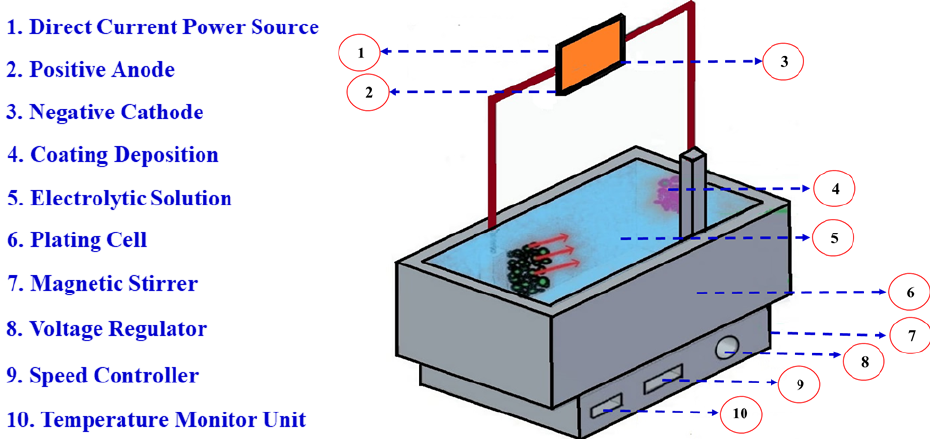
Figure 1. Electrodeposition technique set up used to develop the nanocomposites.